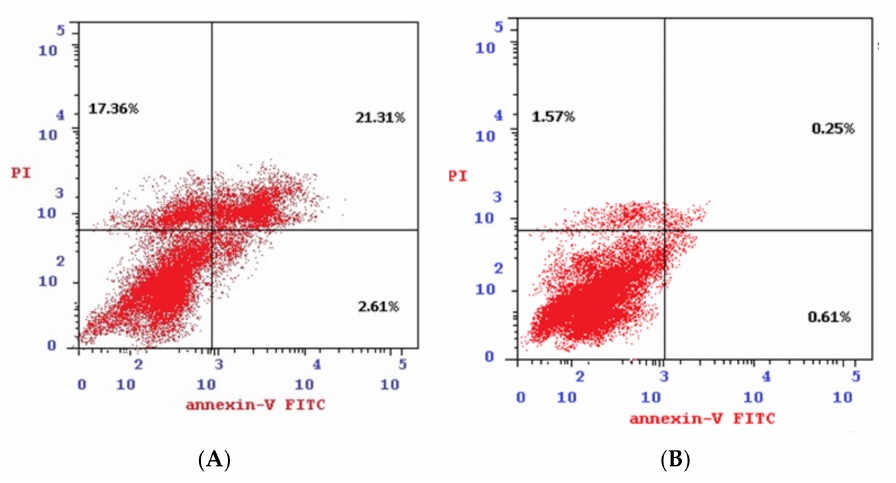
Figure 6. The effect of ( A ) 4b , ( B ) DMSO (control) on the percentage of annexin V-FITC-positive staining in COLO-205 cells. The experiments were done in triplicate. The four quadrants are identified as LL: viable; LR: early apoptotic; UR: late apoptotic; UL: